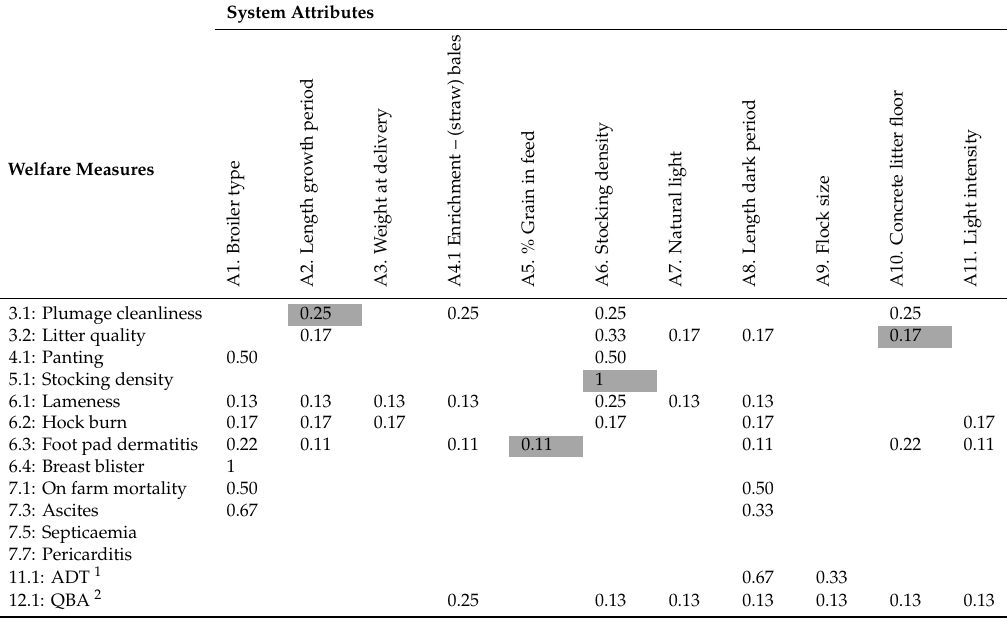
Table 2. Matrix showing weights between the welfare measures and system attributes of the Dutch broiler production